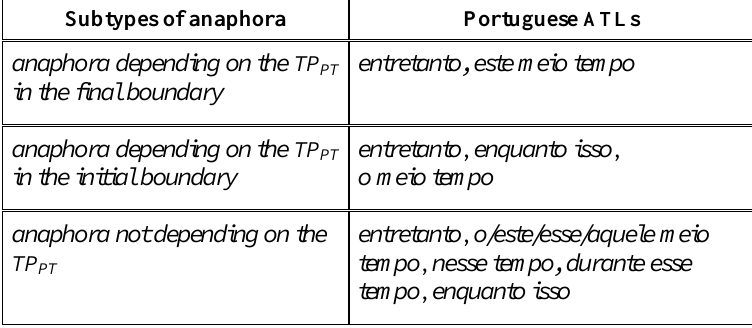
Table 1. ATLs intervening in anaphora involving the inference of time intervals from temporal